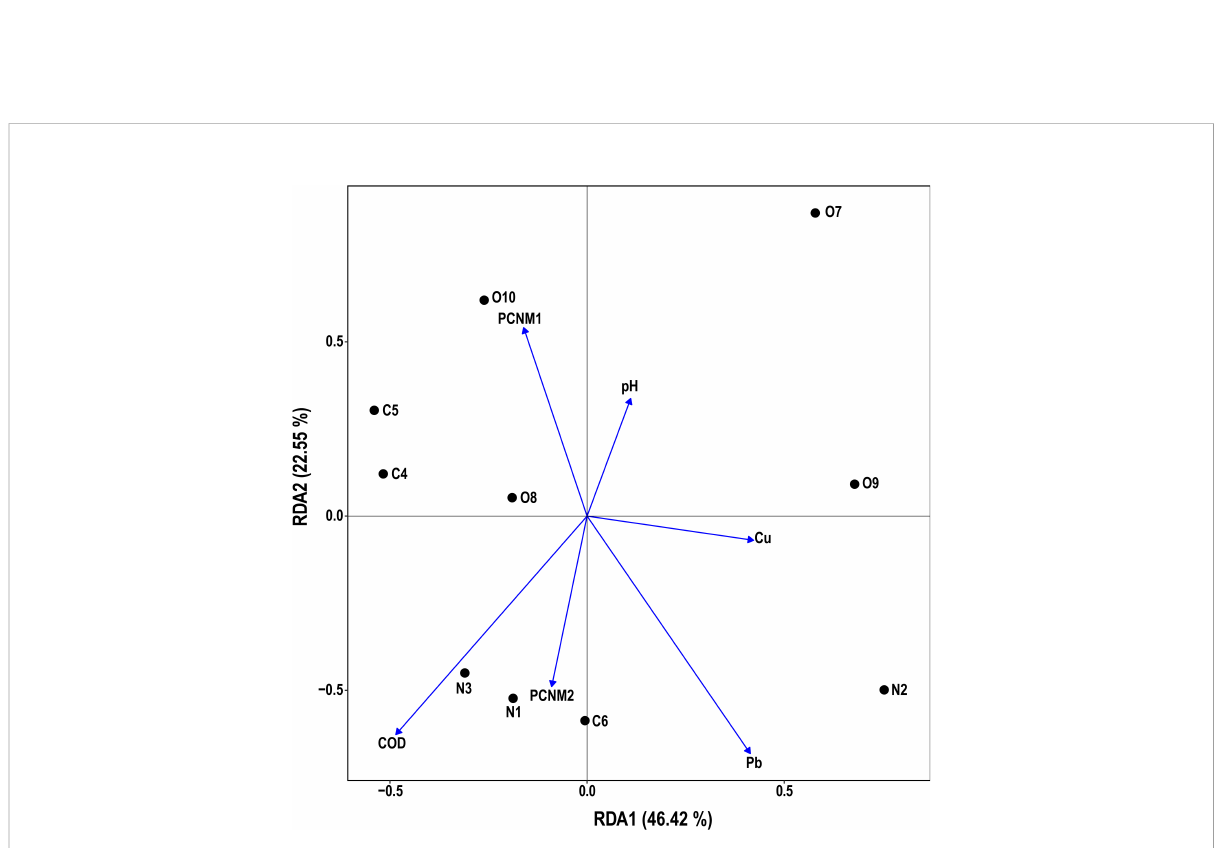
FIGURE 6 A Redundancy analysis (RDA) of environmental/spatial variables and potentially pathogenic bacterial community